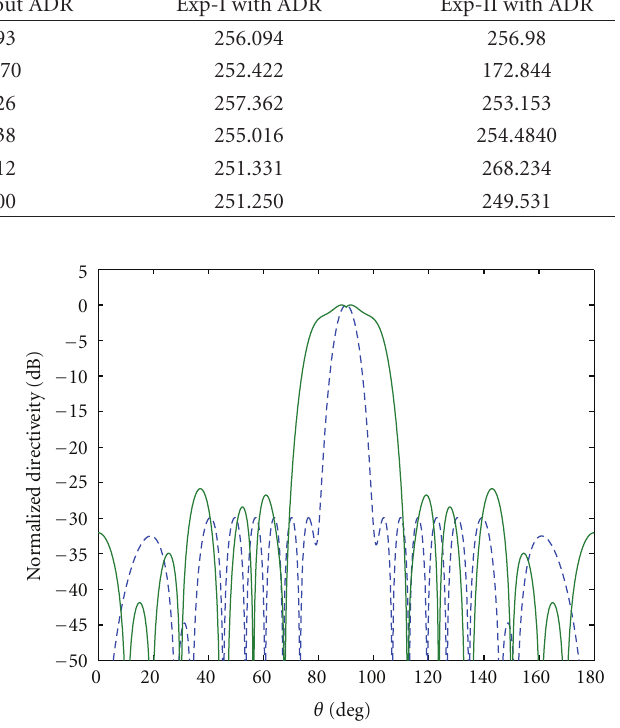
Figure 8: Dual-beam array pattern (Experiment II) with coupling e ff